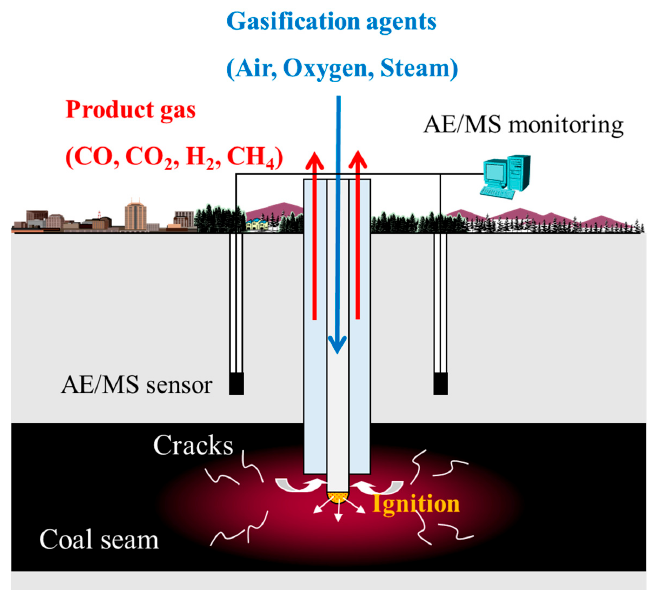
Figure 2. Concept of co-axial UCG system.